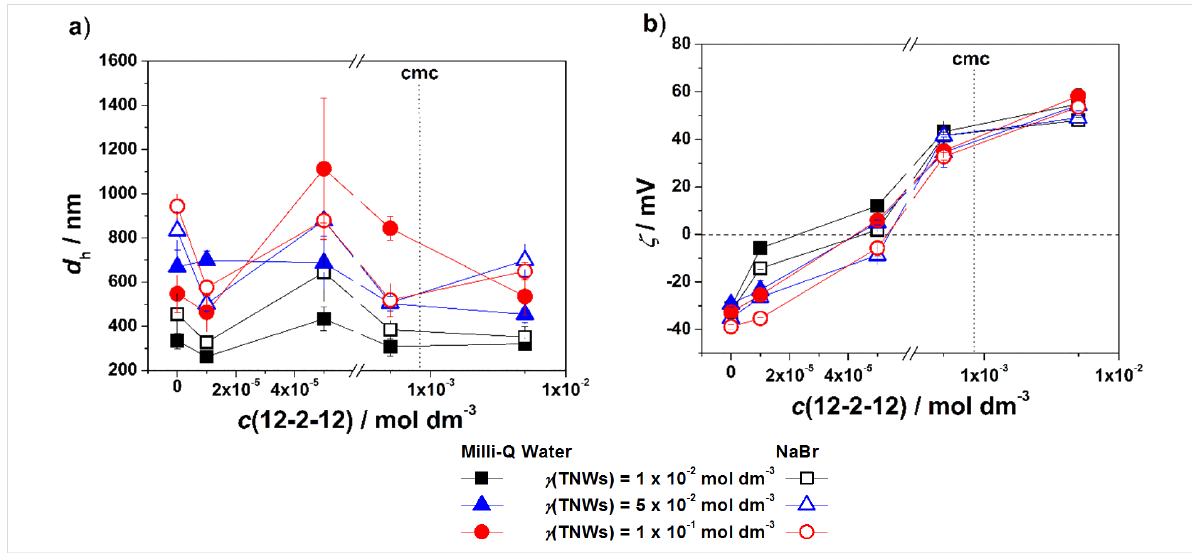
Figure 4: The d h (a) and (b) the zeta potential ( ζ ) of 12-2-12/TNWs in Milli-Q water and 1 × 10 − 3 mol dm − 3 NaBr after 24 h. γ (TNW)/g dm − 3 = 1 × 10 − 2 , 5 × 10 − 2 , 1 × 10 − 1 . θ = 25 °C. The critical micelle concentration (cmc) of 12-2-12 is indicated with dotted line. The lines connecting the data points are a guide for the